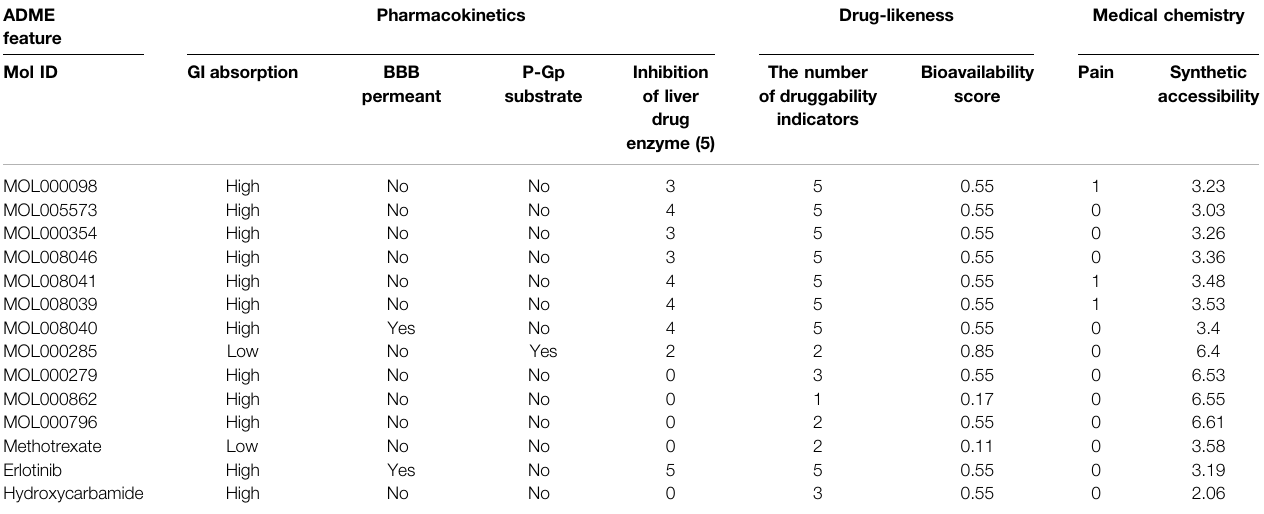
TABLE 4 | The ADME analysis of active components. ADME